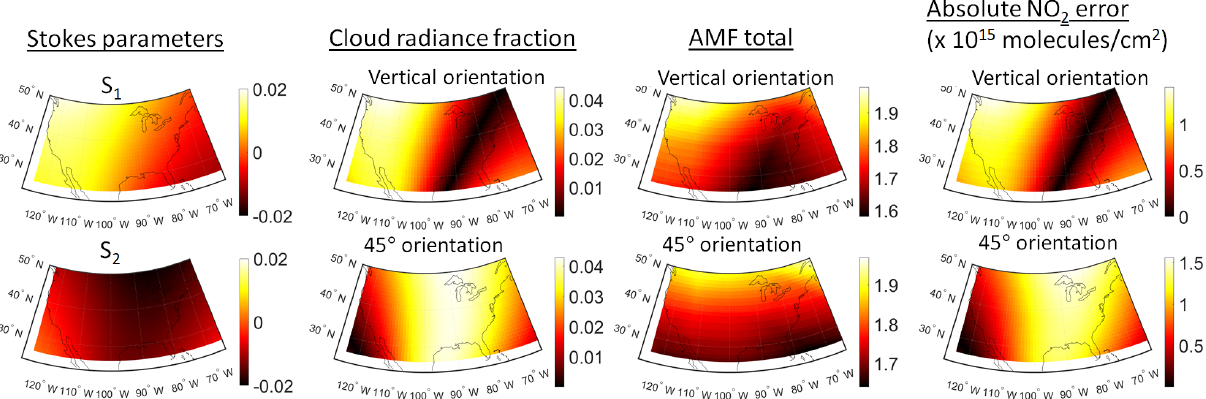
Figure 6. Derived parameters for NO 2 amount of 20 × 10 15 molec.cm − 2 , water scenes, and 5% PS in a vertical and 45 ◦ orientation (see Table 3, Simulation A for more details).